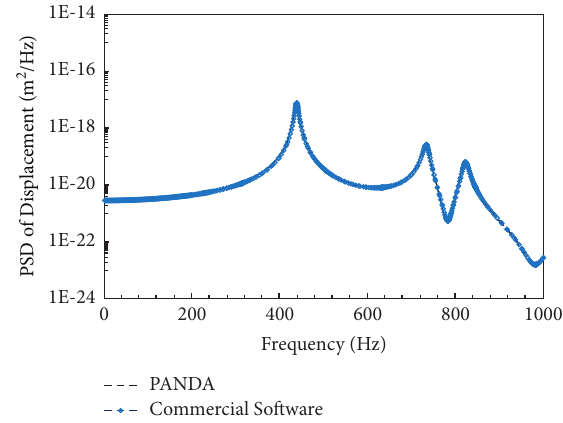
Figure 9: The PSD curves for elastic response.